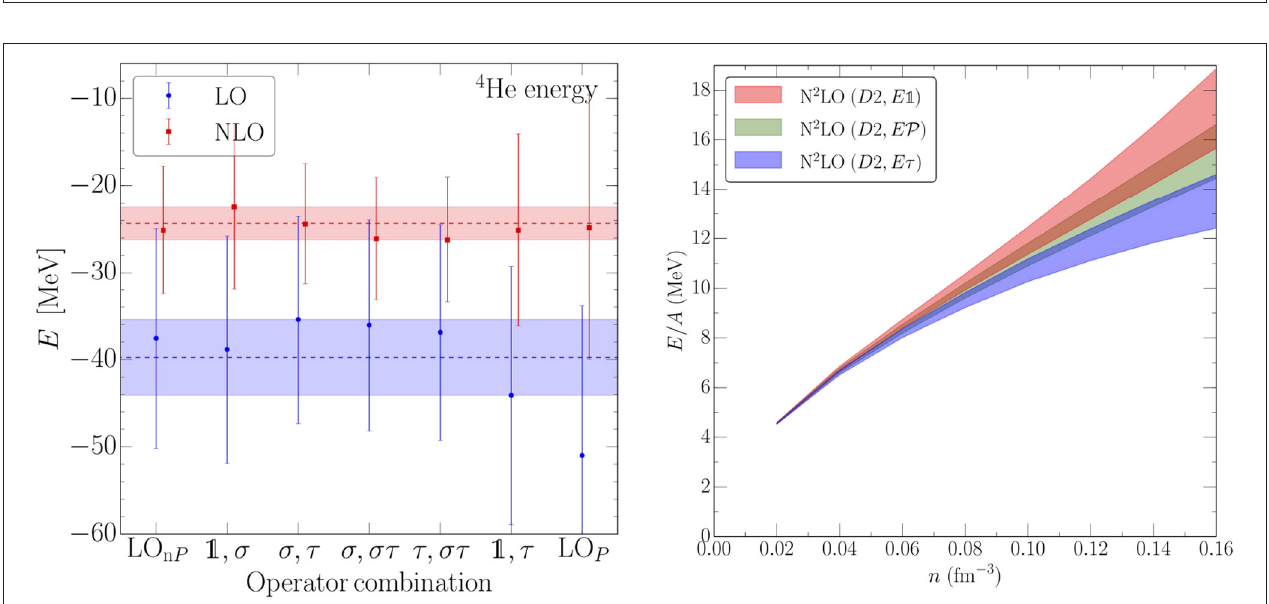
FIGURE 5 | (Left) Ground-state energies of 4 He at LO and NLO for different LO operator choices. Figure taken from Huth et al. [111] under the Creative Commons CCBY license. (Right) Regulator artifacts in pure neutron matter due to the violation of the Fierz rearrangement freedom for the 3 N contact interactions. The three different bands correspond to three different operator choices, where the green band projects the 3 N interaction on triples with S = 1 / 2 and T = 1 / 2. Figure taken from Lynn et al. [91] under the Creative Commons CCBY license.